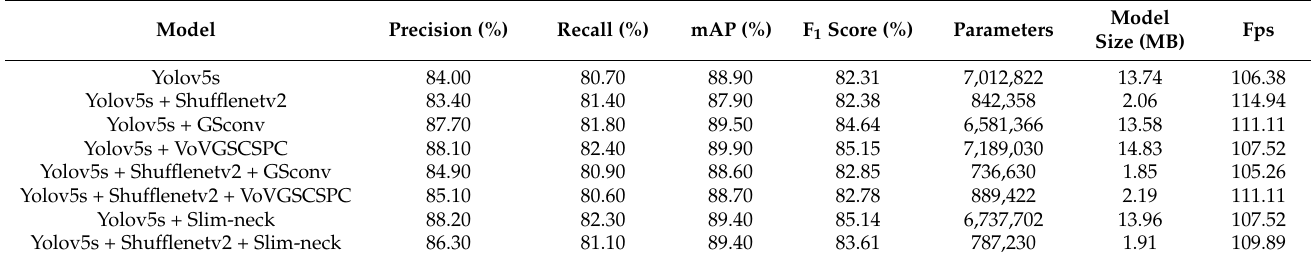
Table 2. Comparative experimental results of improvement